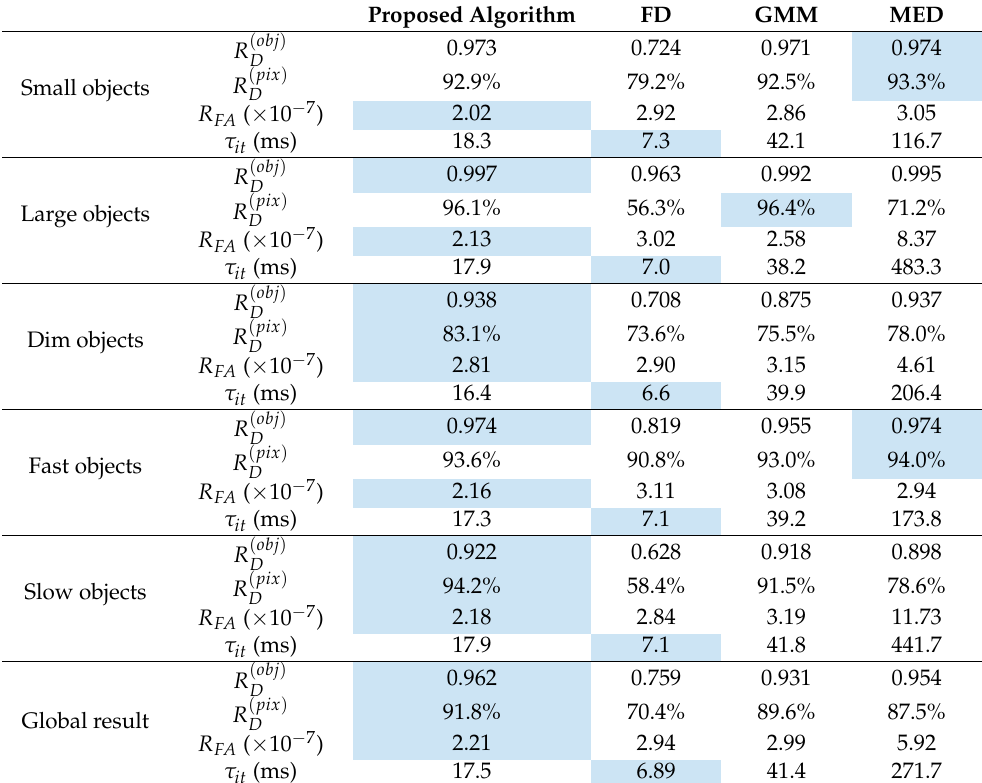
Table 3. Performance of the proposed algorithm in the presence of different kinds of moving objects singularly and globally, and comparison with other commonly used DBT